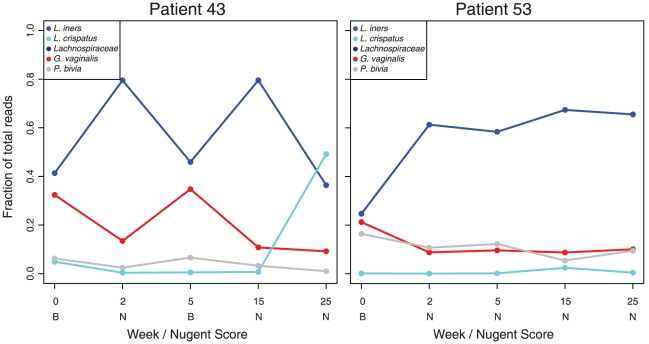
Dynamics of the vaginal microbiota after antibiotic intervention.The line graphs depict the changes in relative abundance for a select number of species after metronidazole intervention (week 0). After two weeks both patients are cleared of BV along with an increase in the relative abundance of L. iners at two weeks. However patient 43 experiences a recurrence and receives another course of metronidazole at 5 weeks. Of note, after an L. crispatus profile is established, BV does not recur in this subject.